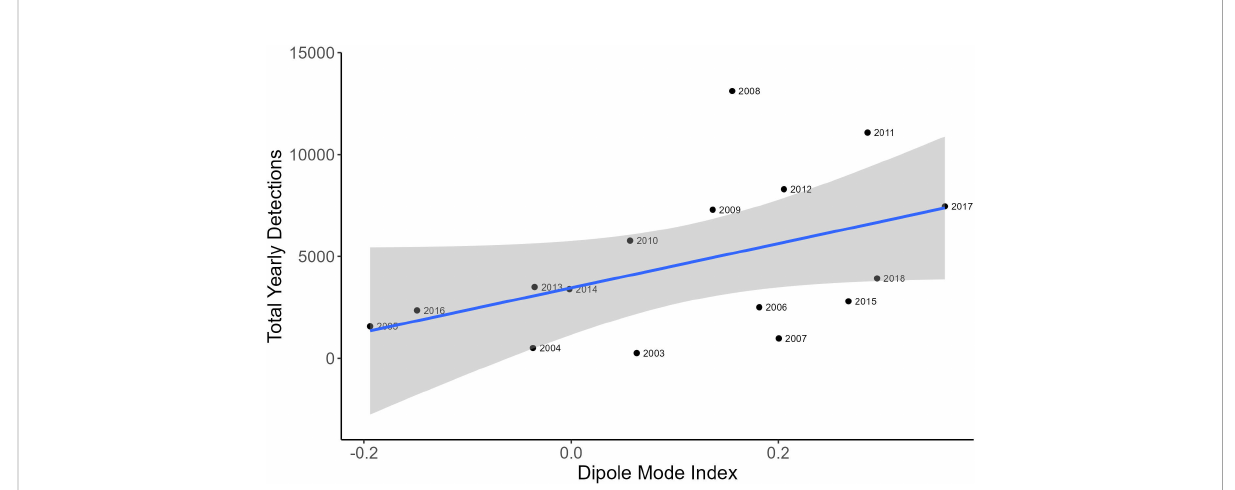
Table 2). Under the principle of parsimony, the second model with three explanatory terms would be the better model as the difference in AIC is only 2.4. Based on the second model SSH (Figure 7A, Coef fi cient estimate = 0.08, SE = 0.05) and SSC.BU (Figure 7B, Coef fi cient estimate = 1.15, SE = 1.0) were positively correlated with monthly whale call detections, while SSC.HP (Figure 7C, Coef fi cient estimate = -10.4, SE = 5.2) was negatively correlated with monthly whale call detections.